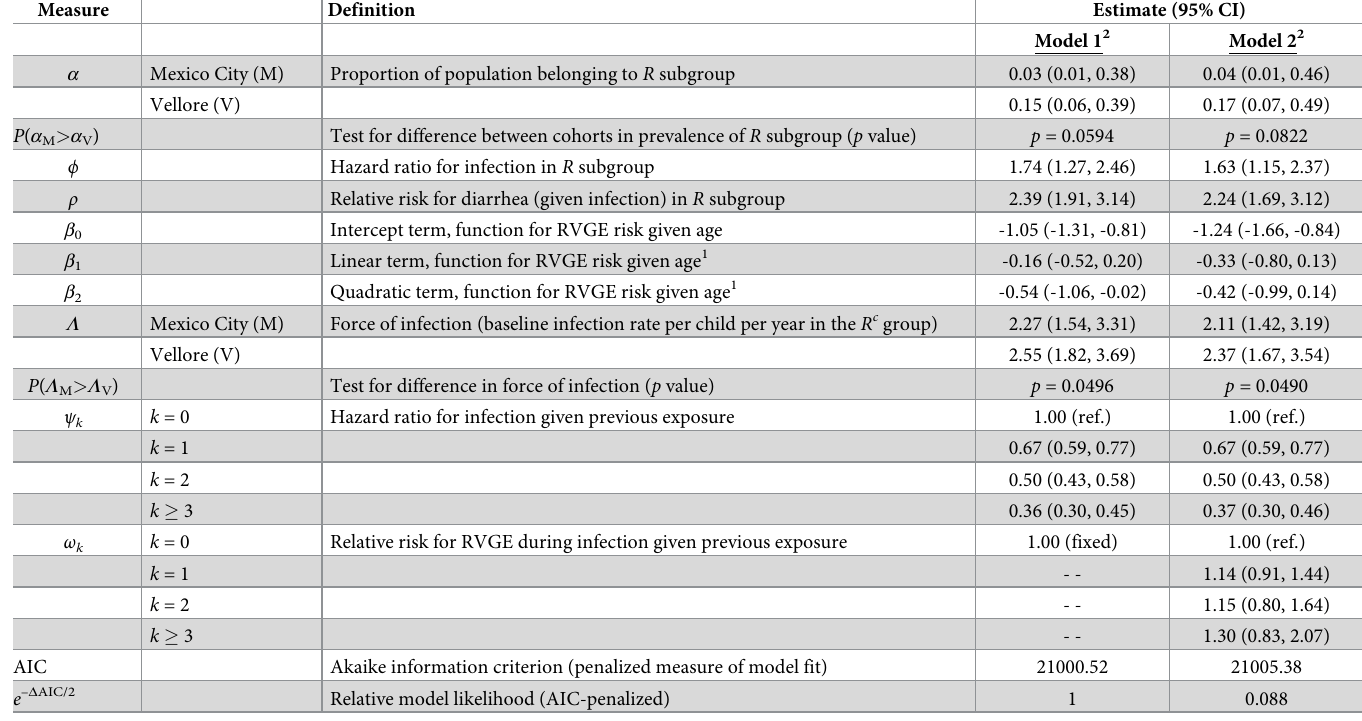
Table 1. Parameter estimates and AIC values from